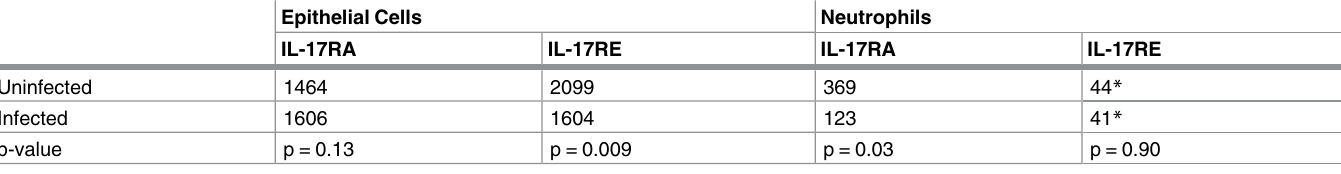
Table 1. Median fluorescence intensity (MFI) of studied receptors. Epithelial